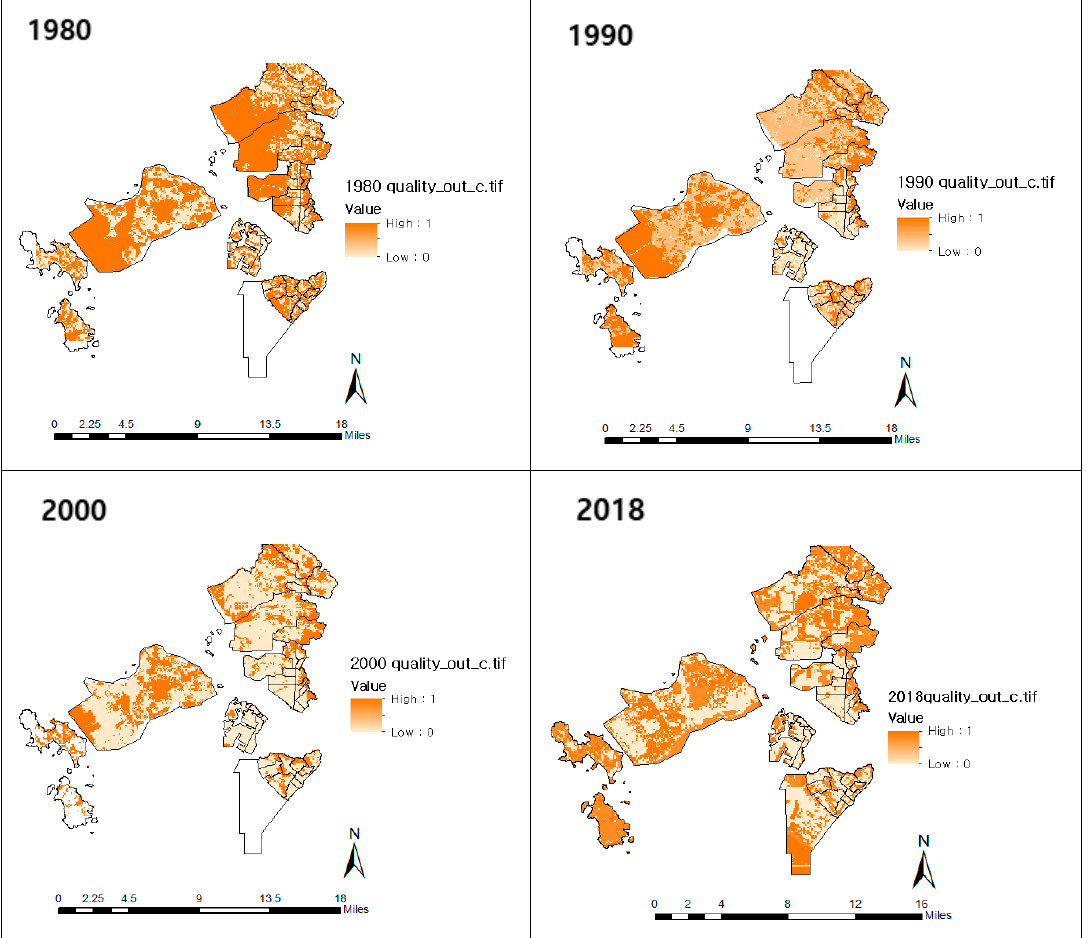
Figure 5. Habitat quality distribution from 1980 to 2018. The white areas (in the bottom right image) were not reclaimed until 2018.